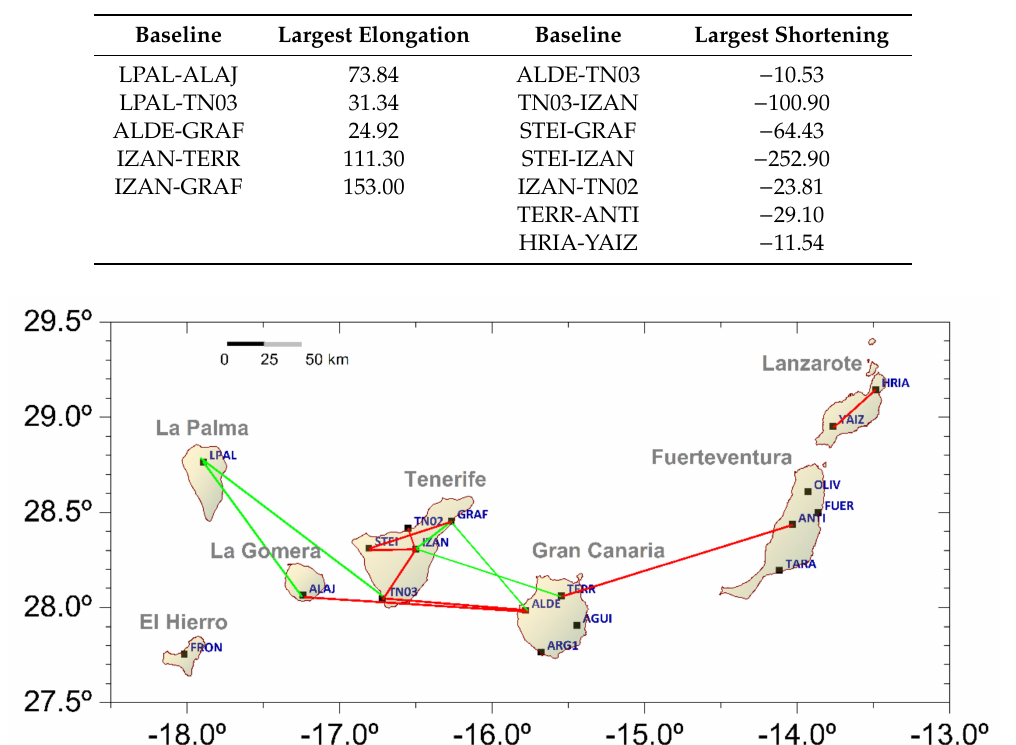
Table 3. Summary of the main tectonic changes as derived from the strain analysis. The elongation / shortening units are 10 − 9 .